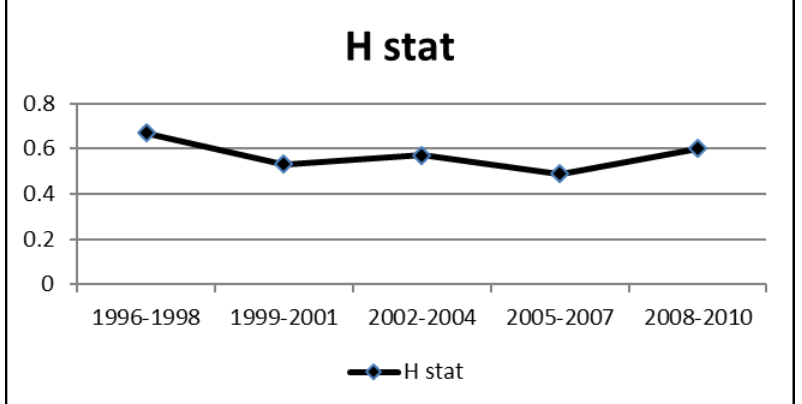
Figure 1: Trends in observed competition measure of Sri Lankan banks 1996-2010 Source: